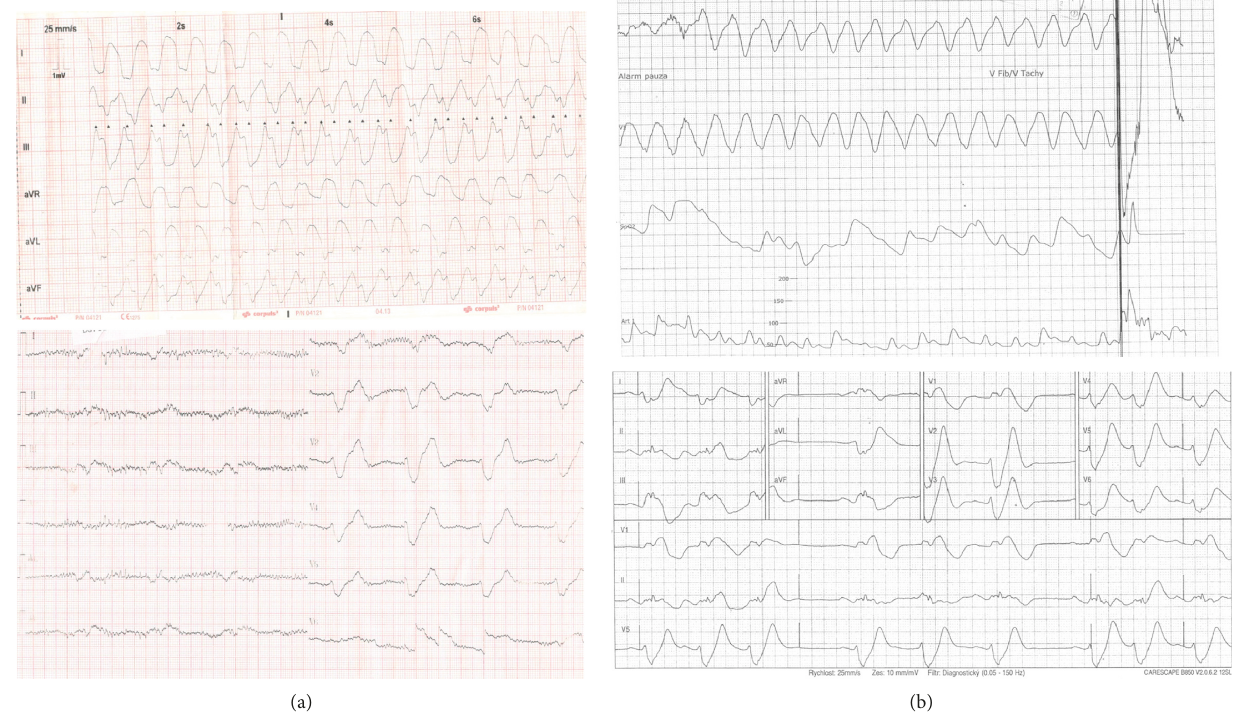
Figure 1: ECG tracings during the index episode of prolonged cardiac arrest (a) and almost a year later